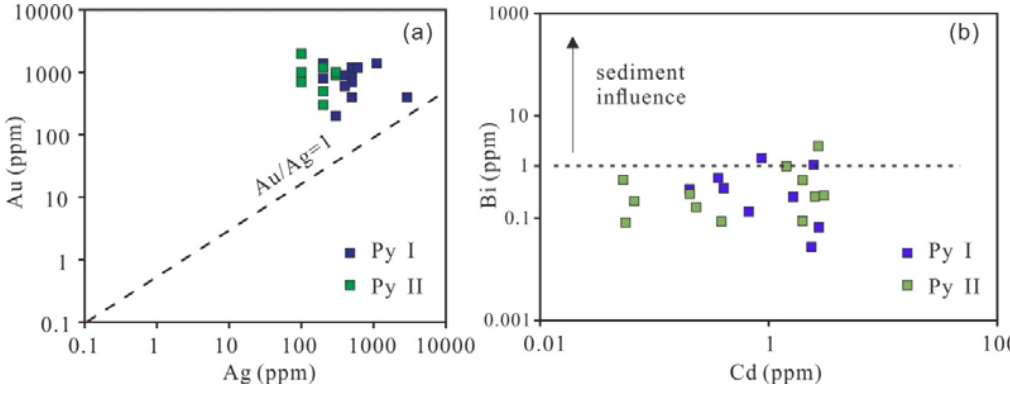
Figure 7. The Au and Ag contents and Au/Ag atomic ratios in pyrite ( a ) and Cd vs. Bi diagram for Pyrite from massive and lamellar ores of the Dongguashan copper (gold) deposit ( b ) (Reference [61]).